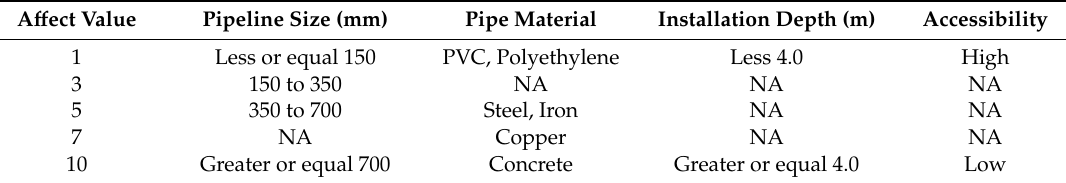
Table 1. E ff ect values of economic criticality